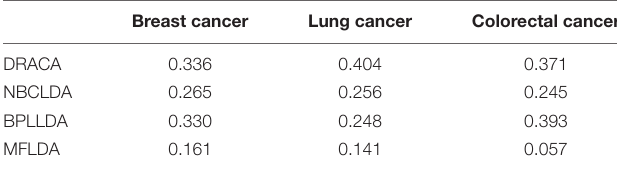
TABLE 4 | Comparing DRACA with three methods on MCC values. Breast cancer Lung cancer Colorectal